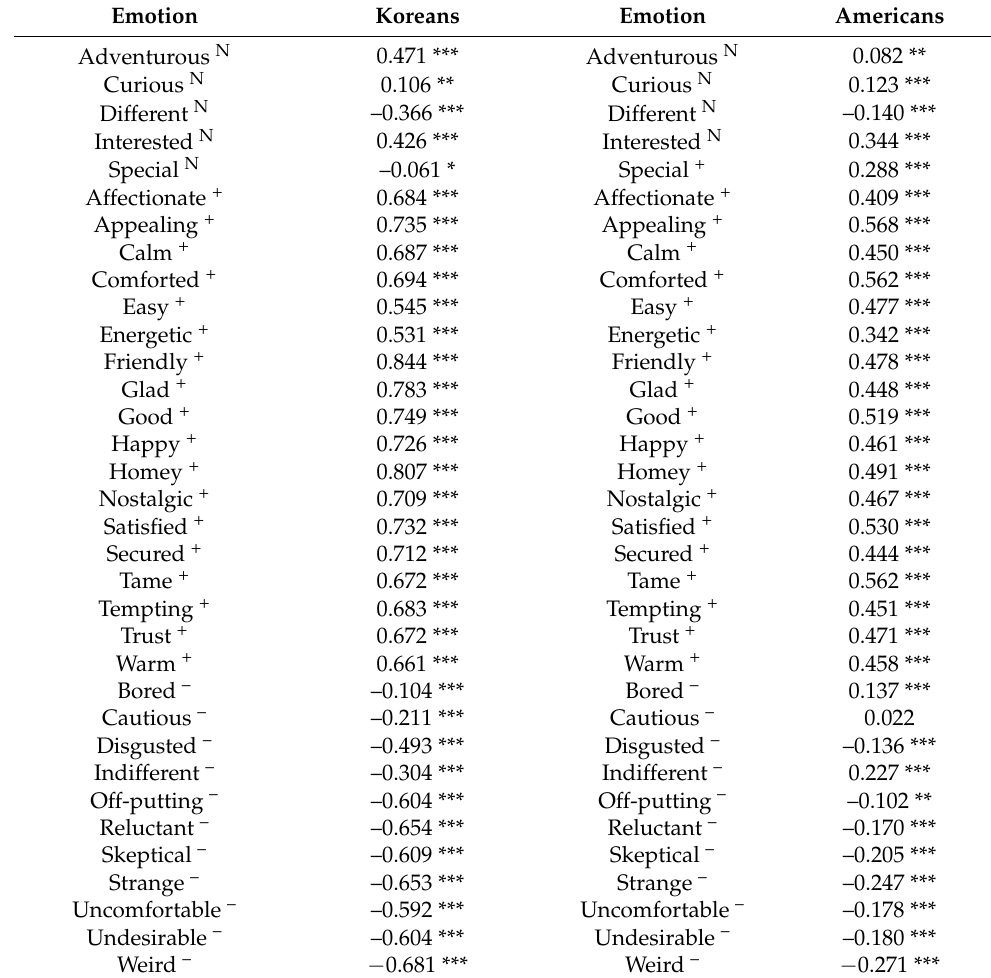
Table 6. Correlations between the familiarity and emotion lexicon items elicited by the stimuli in the Korean and American